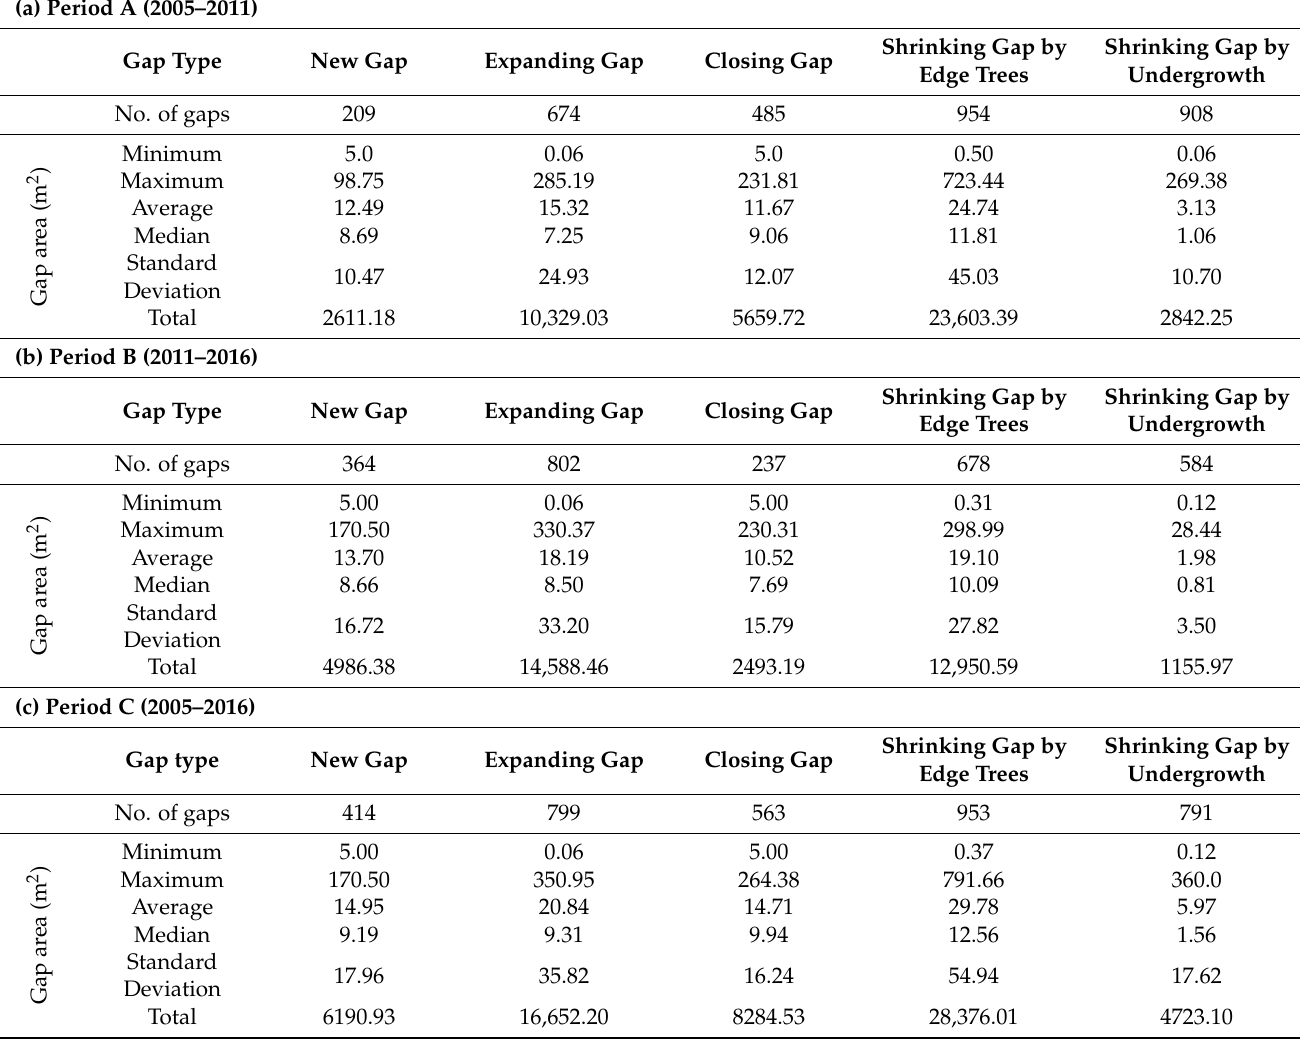
Table 4. Change of gaps over the